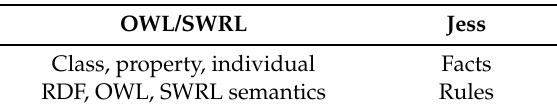
Table 3. The transformation between OWL and Jess.